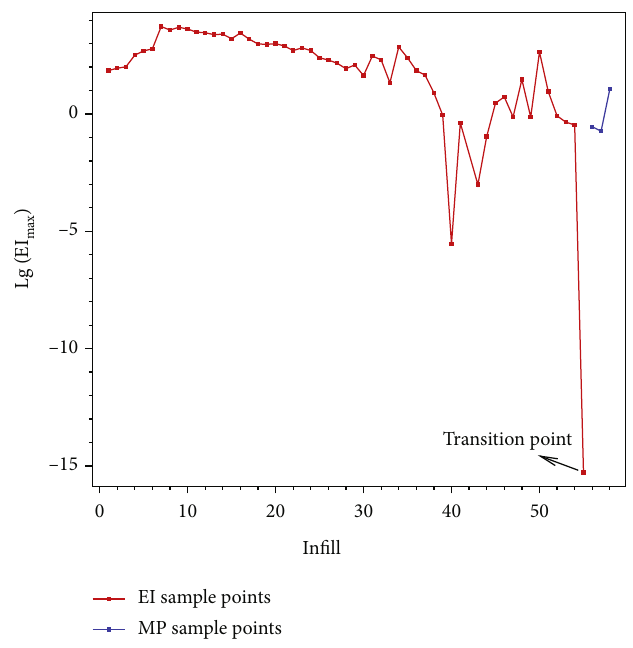
Figure 9: Convergence history of max